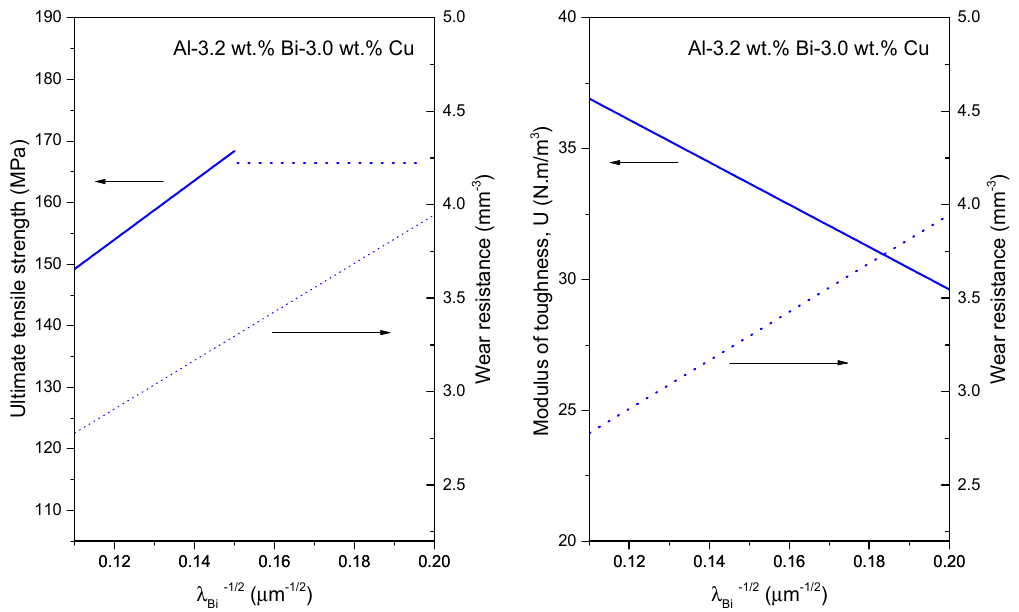
Figure 10. Mapping of the application properties obtained for wear analysis of the DS Al-Bi-Cu alloy. Examples of wear surfaces of craters formed during the wear tests with the Al-Bi(-X) alloys are shown in Figure 11. Results related to two microstructural conditions, refined and coarse, were chosen for each alloy for comparative purposes. It should be noted that, for the Al-3.2 wt.% Bi and Al-3.2 wt.% Bi-3.0 wt.% Zn alloys, there was a predominance of adhesive wear mechanisms, resulting in expressive surface delamination due to the high levels of plastic deformation, as can be observed in Figure 11a,b. Lower toughness of these alloys’ samples in the order of 20 N.m.m − 3 facilitated the occurrence of material pullout failure. Because of the extreme plastic deformations, the higher toughness of the Al-Bi-Cu alloy samples tends to be able to minimize the detachment processes. As such, higher wear resistance is achieved. On the other side, a more scratched surface concurring with the sliding path was shown by fine and shallow grooves in the Al-3.2 wt.% Bi-3.0 wt.% Cu alloy (see Figure 11c).